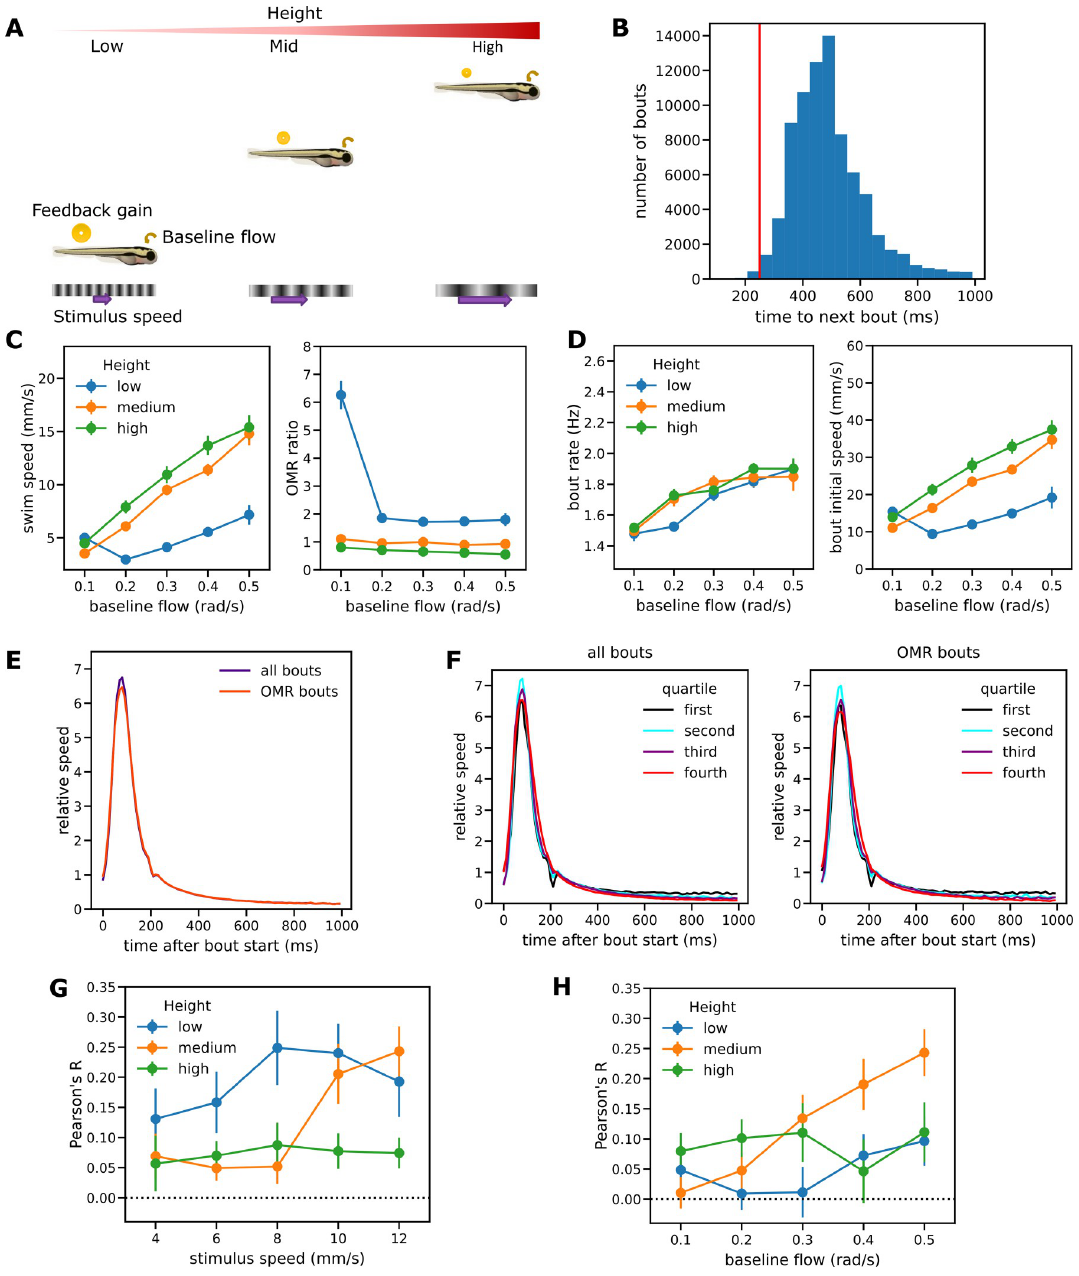
Fig 3. Experimental results for the baseline flow experiment and bout analysis. (A) Baseline optical flow procedure. Each fish is tested at one of three different heights with the stimulus speed increased in proportion to height. Feedback gain decreases as the height increases but the baseline optical flow remains constant. (B) Histogram of intervals from the start of one bout to the start of the next for OMR-consistent bouts pooled from both procedures. The interval exceeded 250ms for 99.5% of bouts C) Mean swim speed and OMR ratio for the baseline flow procedure. (D) Bout patterns for the baseline flow procedure. Bout speed increased with height, but bout rate did not. (E) Overall relative bout speed profile from both experiments for all observed bouts and for OMR-consistent bouts only. The profile was not sensitive to the behavioral context. (F) Separate relative speed profiles for bouts split into quartiles by initial bout speed (swim speed averaged over the first 100ms of a bout). The relative speed profiles were essentially independent of the absolute bout speeds and again similar for all bouts (left) and OMR-consistent bouts (right). (G-H) Bout speed and time to next bout were positively correlated for OMR-consistent bouts in both the OMR regulation (G) and baseline flow procedures (H).